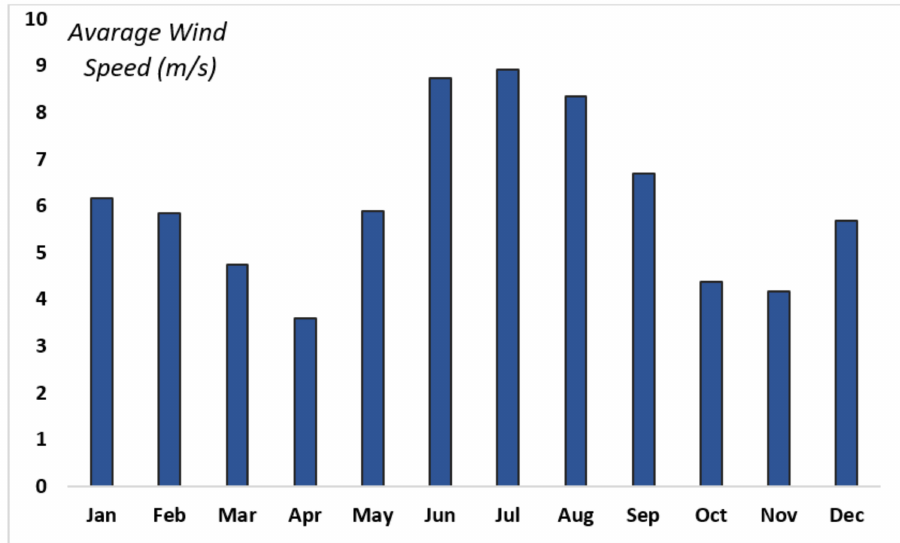
Figure 3. Monthly variation of the mean wind speed.